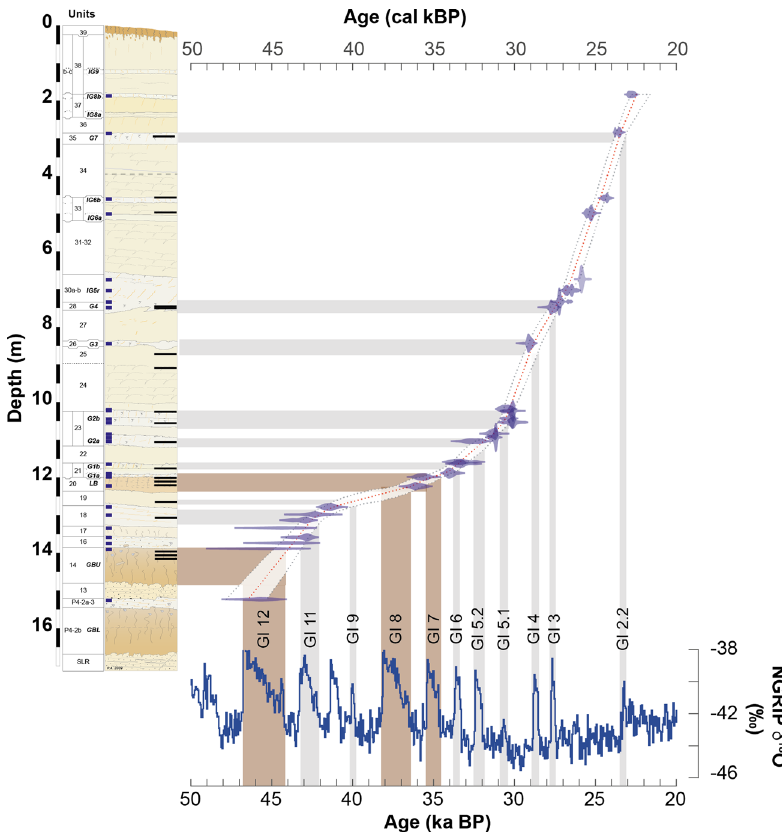
Fig. 3 Age-depth model of the Nussloch loess pro fi le P8. Age-depth model is based on Bayesian modelling using the software Bacon 51 with 29 radiocarbon ages 11 calibrated with IntCal20. The chronology of the pro fi le is correlated with the δ 18 O values of NGRIP 3 . Tundra gley horizons are represented in grey and arctic/boreal brown soils in